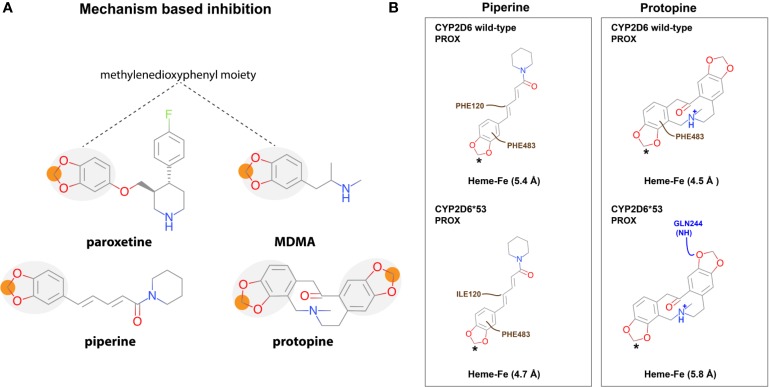
Mechanism based CYP2D6 inhibition. (A) Piperine and protopine both contain a methylenedioxyphenyl moiety which has been associated with mechanism-based inhibition (MBI) of CYP2D6 (e.g. paroxetine and MDMA are CYP2D6 MBI). (B) The best scored binding mode (in 2D) for each is shown in CYP2D6 WT and CYP2D6*53. The asterisk indicates the atom closest to the heme-iron. Color code: hydrophobic interactions; brown, electrostatics; purple, and hydrogen bonds; blue.